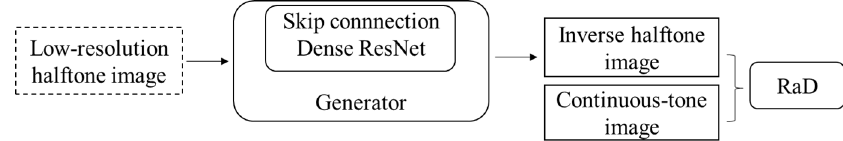
Figure 10. The architecture of ESRGAN. The generator is used to produce an inverse halftone image from its low-resolution halftone image, and the RaD is a discriminator for judging whether the inverse halftone image is a continuous-tone image.